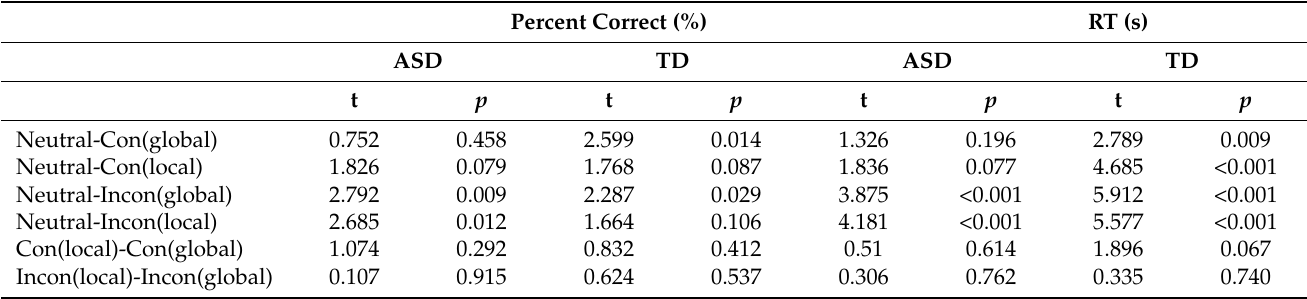
Table 3. Pairwise comparisons of post hoc